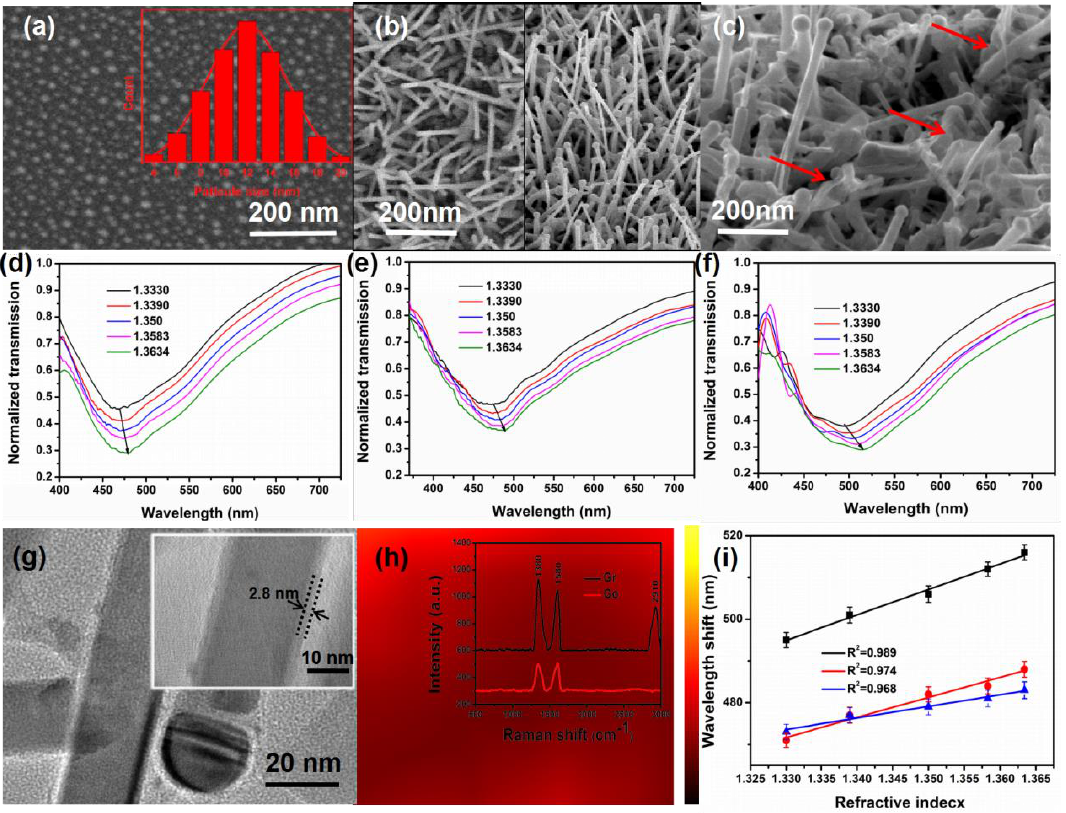
Figure 6. ( a ) Distribution of annealed Au particles. ( b ) Frontal profile of ITO (right figure shows the ITO with the preannealing process and the left exactly the opposite). ( c ) Surface morphology of Gr/ITO-NM/U-bent-A/0.04/20. ( d – f ) The absorption spectra of ITO-NM/U-bent/0.04/20, ITO-NM/U-bent-A/0.04/20, Gr/ITO-NM/U-bent-A/0.04/20 sensors in alcohol solution with RI from 1.3330 to 1.3634. ( g ) TEM diagram of Gr/ITO-NM/U-bent-A/0.04/20. ( h ) 2910 cm −1 peak mapping (20 × 20 μm 2 ) of graphene and the insert pattern is Raman diagrams of graphene and graphene oxide on Gr/ITO-NM/U-bent-A/0.04/20 sensor. Figure S1 shows 15 groups of Raman spectra collected from different sensors. ( i ) The relationship between resonance wavelength and refractive index of ITO-NM/U-bent/0.04/20, ITO-NM/U-bent-A/0.04/20, and Gr/ITO-NM/U-bent-A/0.04/20.